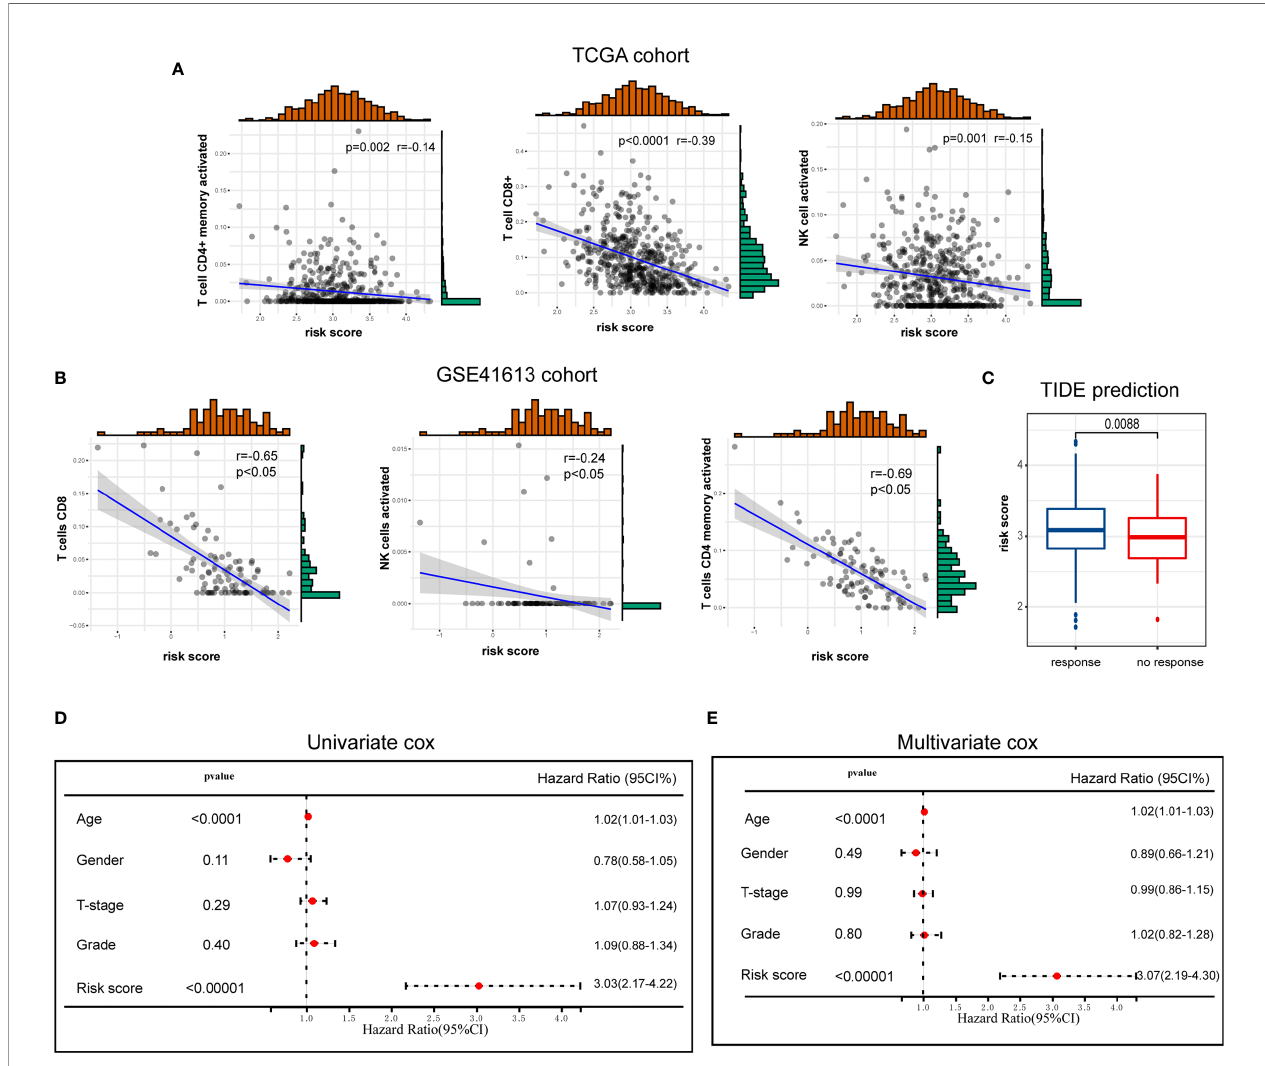
FIGURE 6 | The association of ICD risk signature with tumor microenvironment. (A, B) Scatter plots show the correlation of risk score with the in fi ltration of CD8, activated NK cell, and activated CD4 memory cell (A) , which was further validated by GSE41613 cohort (B) ; (C) Box plot presents the association of ICD risk score with immunotherapy response; (D, E) Univariate and multivariate Cox analyses evaluate the independent prognostic value of ICD risk signature in HNSCC